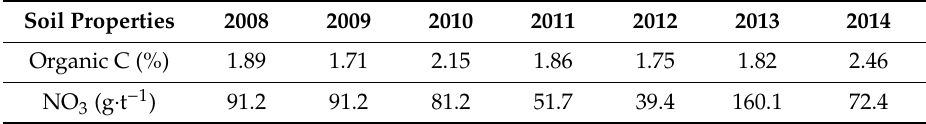
Table 2. Soil organic carbon and nitrate concentration in each evaluated year. Values correspond to soil samples taken at planting date, in the sowing area of forage and grain sorghum.